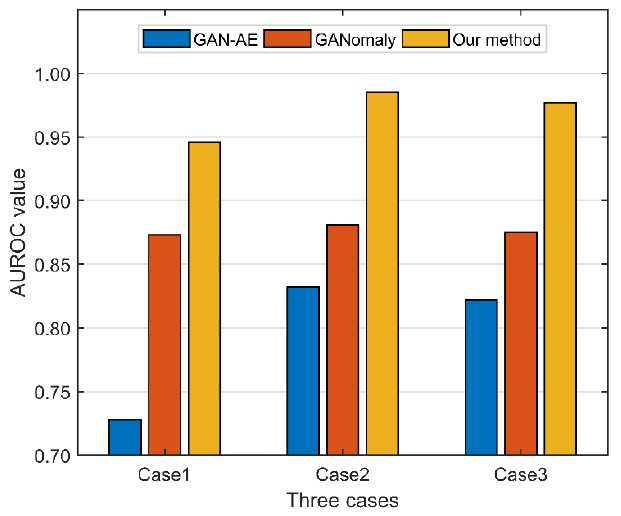
Figure 13. Histograms of experimental results for three methods under three input conditions.